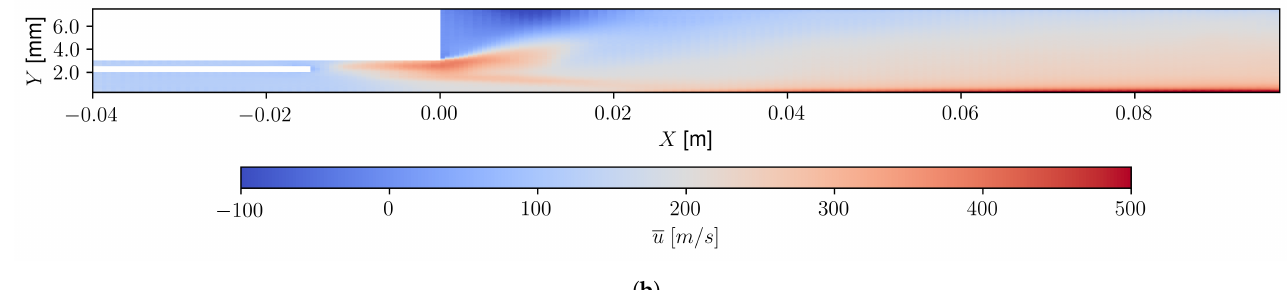
Figure 15. Velocity-u (axial component) field as given by the corresponding u U-Net. ( a ) DP-A and ( b ) DP-C. The aspect ratio of the figures has been modified purposely to facilitate their